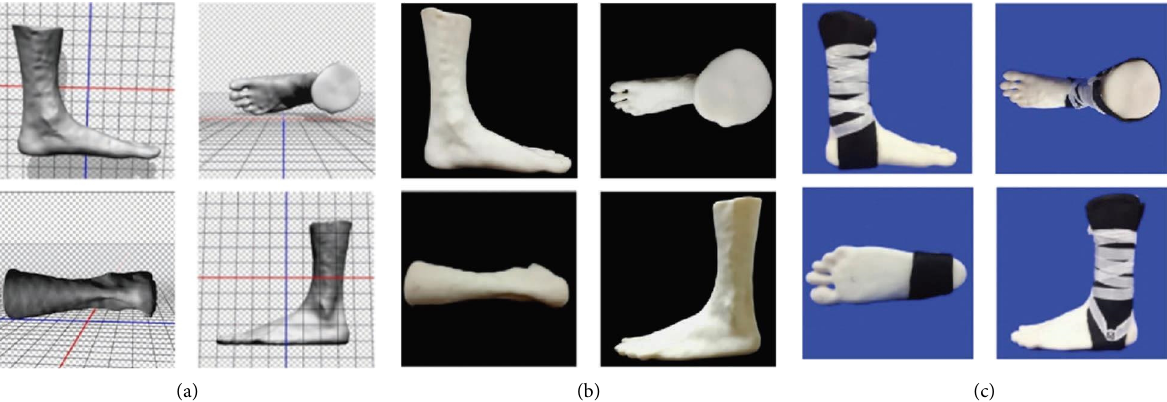
Figure 22: Schematic of 3D foot model: (a) digital model of ankle, (b) photos of 3D printed model, and (c) photos of foot model wearing ankle brace with asymmetric